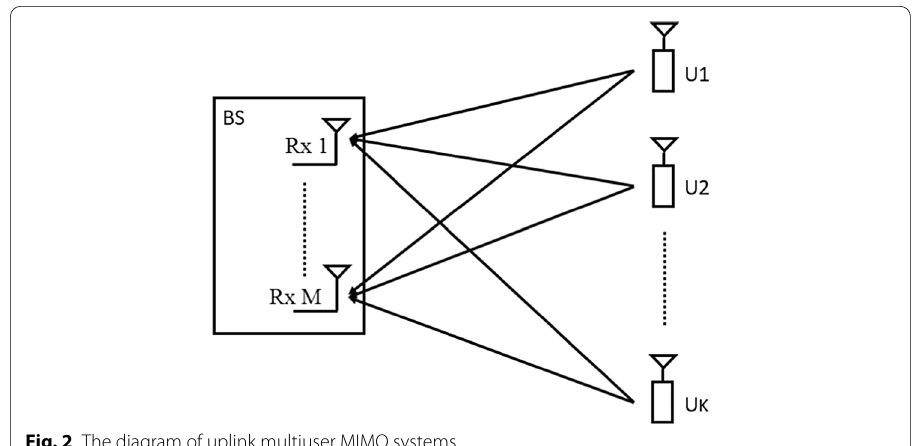
Fig. 2 The diagram of uplink multiuser MIMO